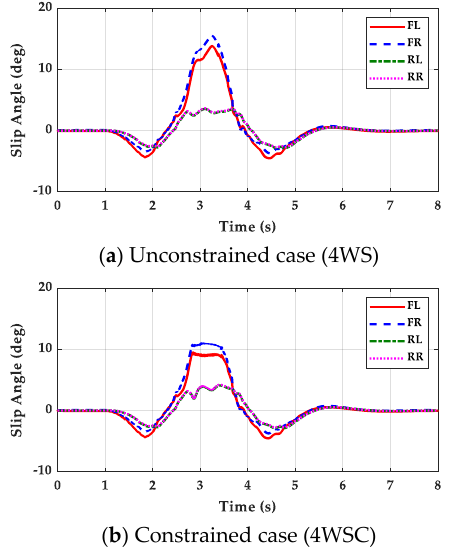
Figure 5. Slip angles for unconstrained and constrained cases.